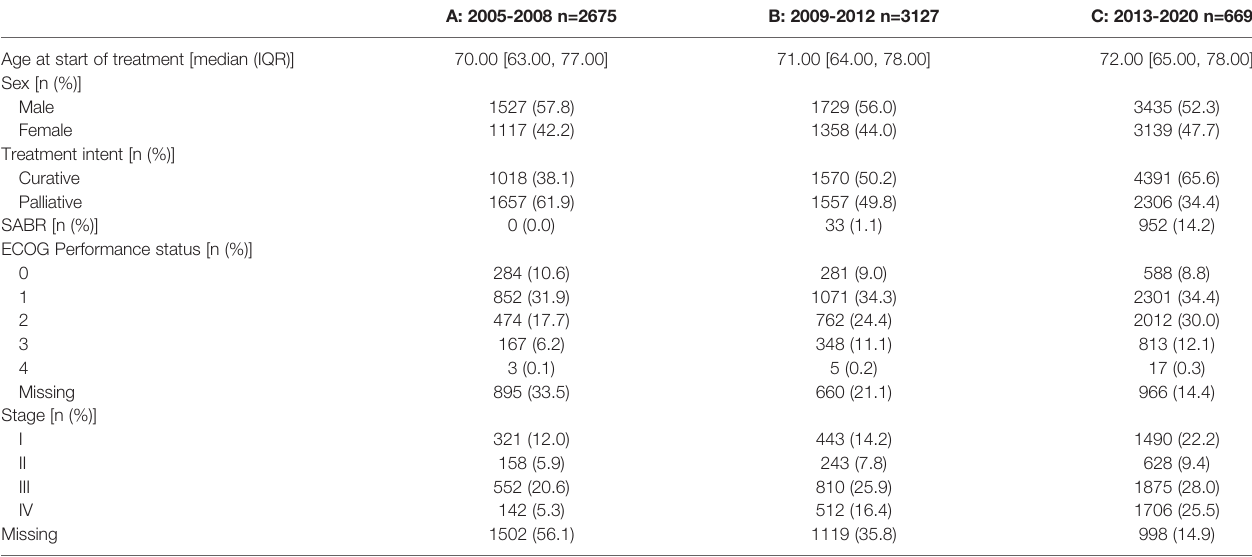
TABLE 1 | Baseline characteristics.